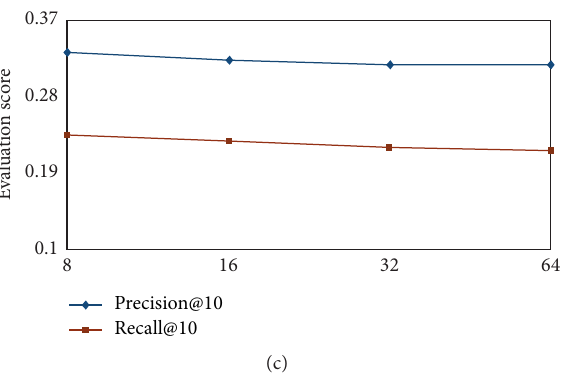
Figure 4: Parameter tuning of TANN on MovieLens dataset. (a) The embedding size for the weighting vector of attentive scores. (b) The number of negative samples. (c) The embedding size for the output